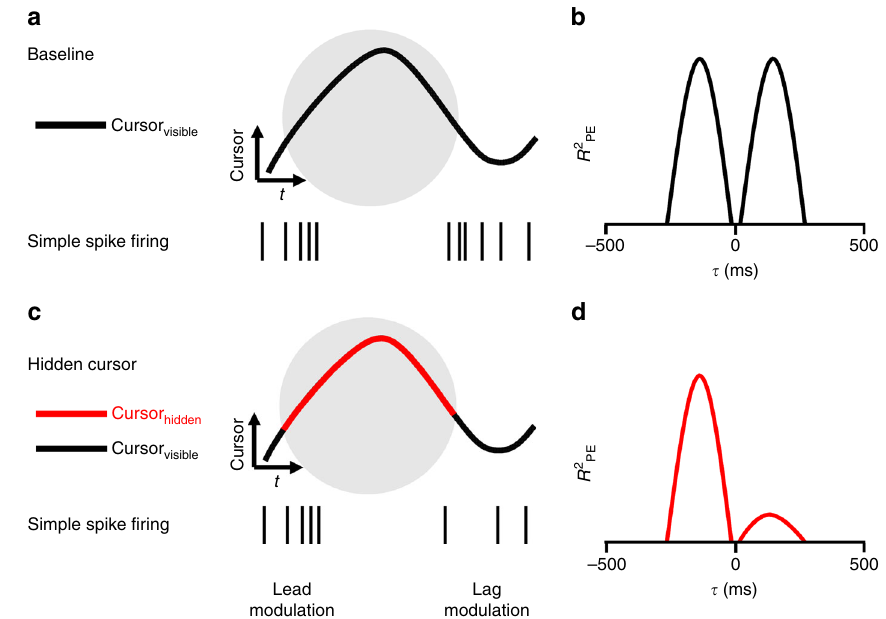
Fig. 5 Rationale for the hidden cursor experiment and expected results. a In the baseline condition, the cursor (black trace) is visible whether inside or outside of the target (gray circle). Simple spike fi ring both leads (left spike train) and lags (right spike train) the cursor movement. b Temporal R 2 pro fi le of the SS fi ring with the position error (PE) includes a leading ( τ < 0) and lagging ( τ > 0) peak. c In the hidden condition, the cursor is visible only when outside the target (black trace) and invisible within the target (red segment). Based on a forward model, the lead SS fi ring will not be affected, but the lag fi ring will be reduced. d In the hidden condition, the lead R 2 peak will be unchanged and the amplitude of the lag R 2 peak will be modulation (Fig. 7a, F (1,35) = 10.65, p = 0.0026, ANOVA). The